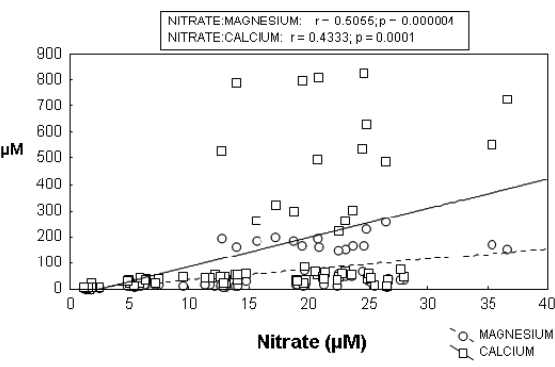
Figure 5 - Plot of concentration of nitrate (µM) and magnesium and calcium (µM) of stream water collected at undisturbed (1, 2, 3, 4, 5, 6) and disturbed sites (7, 8, 9,